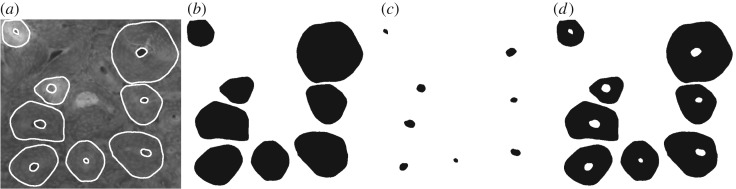
Visualization of measured data. (a) Close-up of some of the intact secondary osteons and their Haversian canals from a hippopotamus humerus (Bd 167), traced in white (image © The Royal College of Surgeons of England, reproduced here by their kind permission) (image width: 1.03 mm). (b) Binary file created to measure the osteon areas. (c) Binary file created to measure the canal areas. (d) Binary file created by subtracting the previous binary files from each other to measure the infill areas.